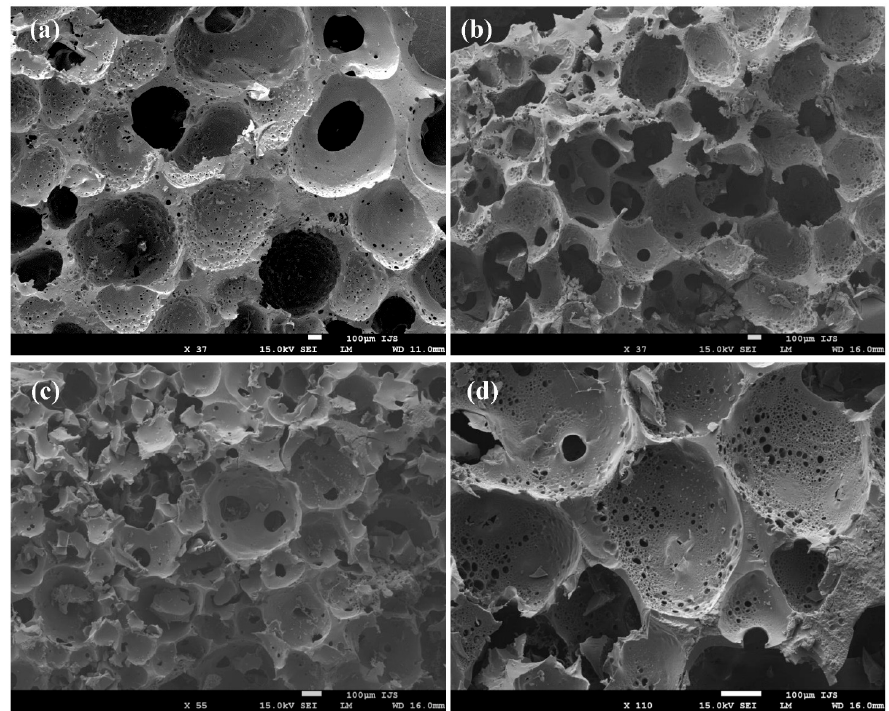
Figure 2. SEM micrographs of a cross-section of ( a ) PHEMA/G/TiO 2 , ( b ) PHEMA/70G/30A/TiO 2 , ( c ) PHEMA/50G/50A/TiO 2 and ( d ) PHEMA/A/TiO 2 hybrids (the bar is 100 μ M). ( c ) PHEMA/50G/50A/TiO 2 and ( d ) PHEMA/A/TiO 2 hybrids (the bar is 100 µ